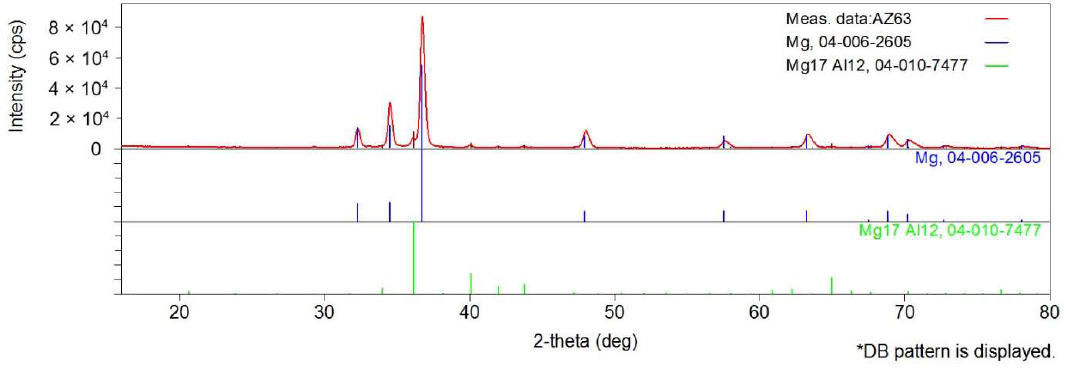
Figure A1. AZ63 alloy—XRD qualitative phase analysis with displayed PDF cards peak bars.